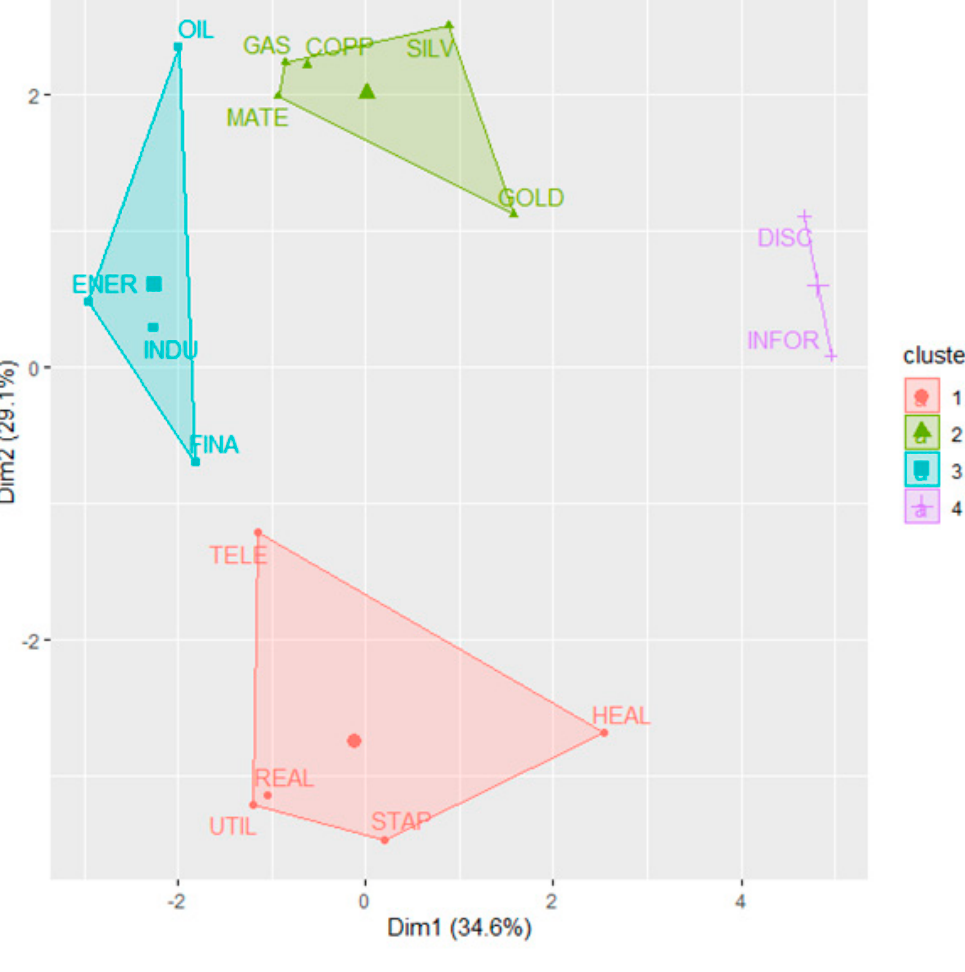
Figure 5. Cluster analysis results for time scale 6.